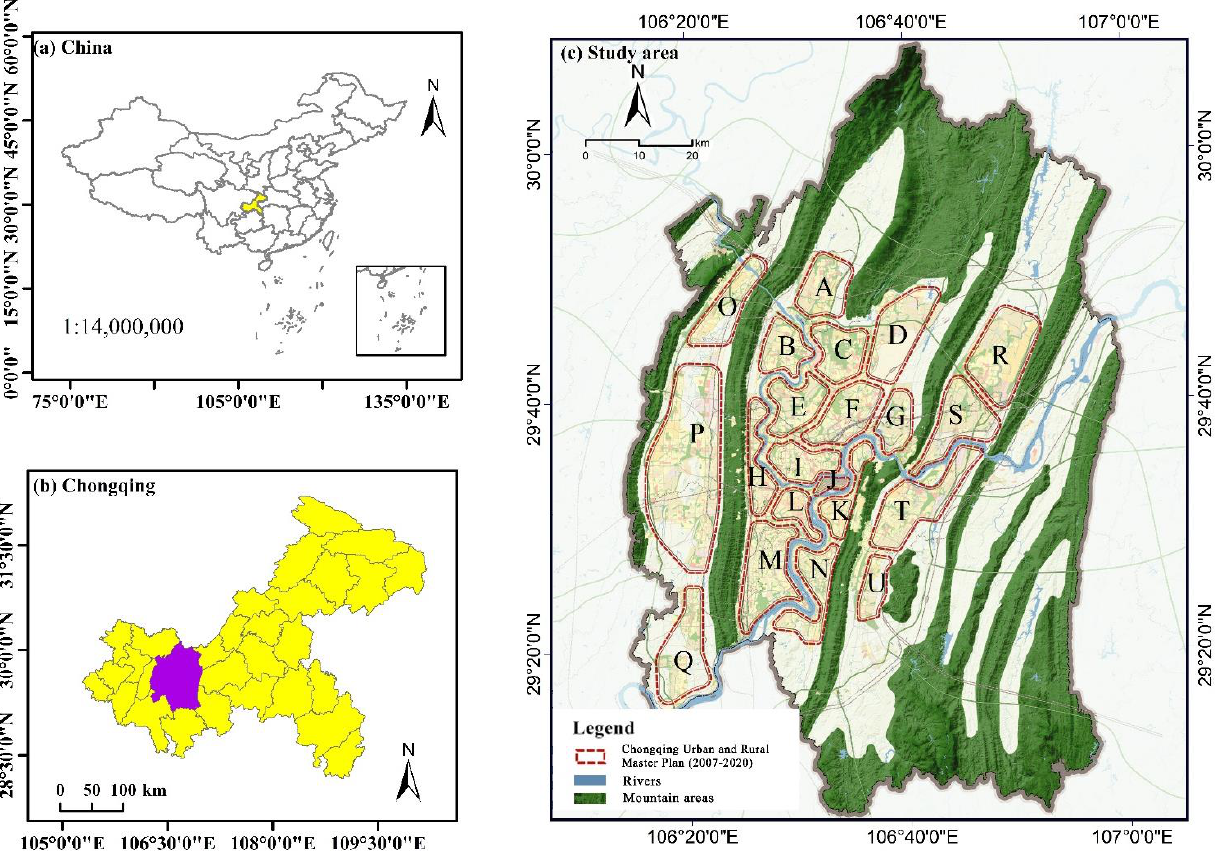
Figure 1. The study area of central Chongqing. ( a ) Map of China: it was obtained from the Ministry of Natural Resources of the People’s Republic of China website